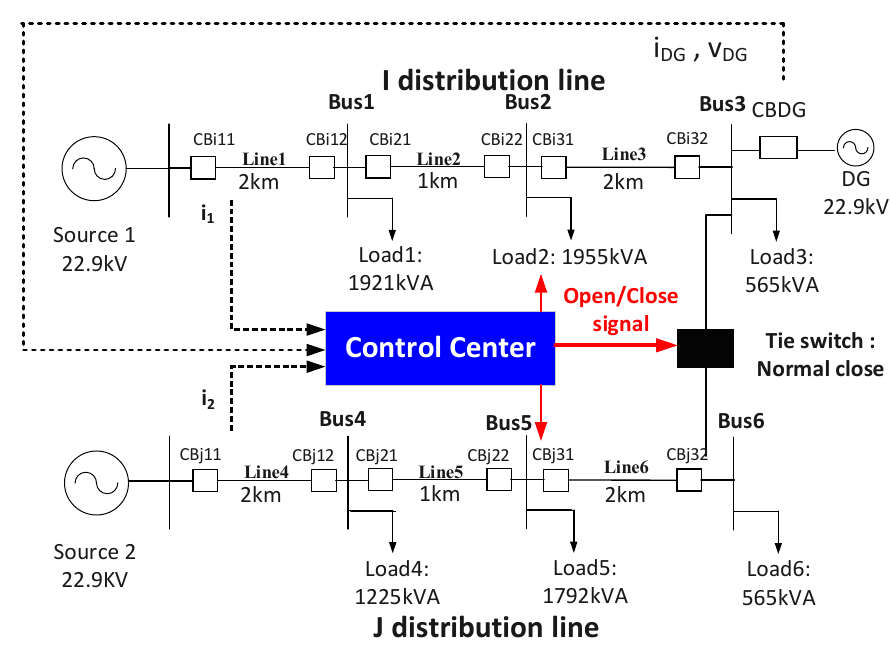
Figure 6. Loop distribution model with DG.